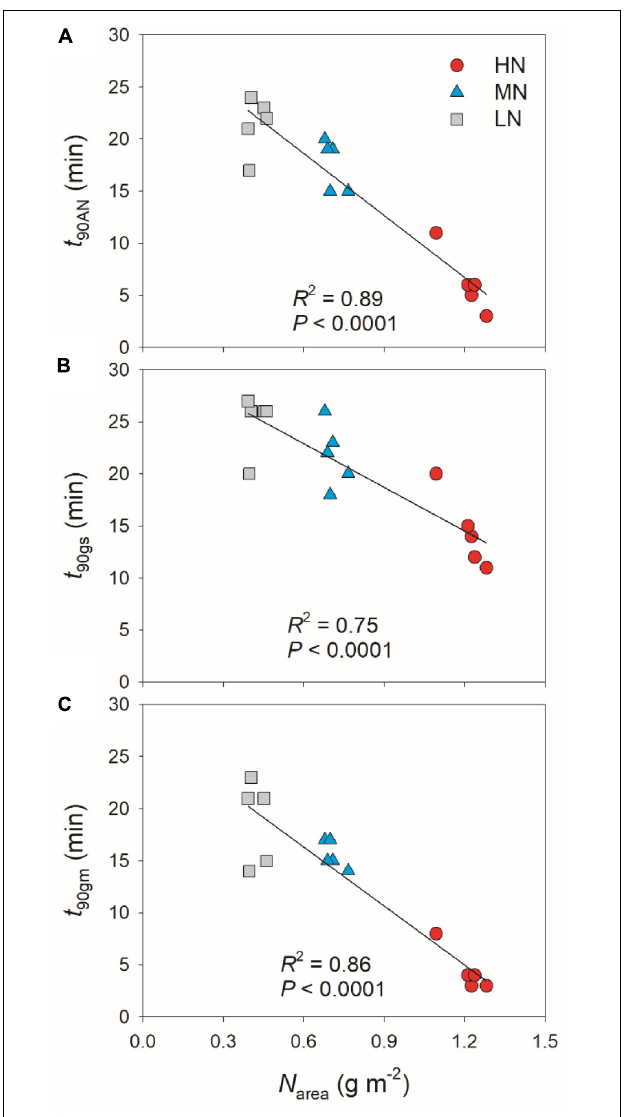
FIGURE 2 | Effects of leaf N content on the time required to reach 90% of the maximum values of A N (A) , g s (B) , and g m (C) ( t 90 AN , t 90 gs , t 90 gm ) after transition from 50 to 1,500 µ mol photons m − 2 s − 1 . HN, MN, and LN represent tomato plants grown under high, medium, and low N concentrations, respectively.